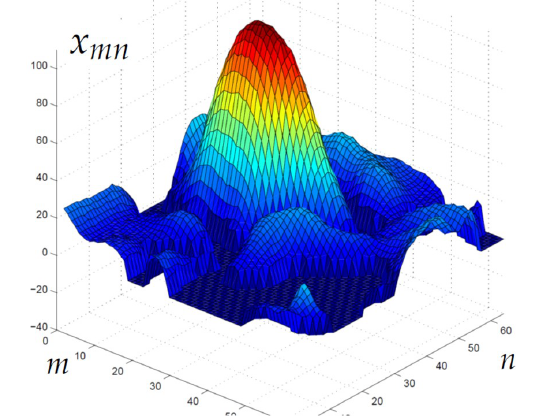
Figure 7. Oceanographic field ( N = 64 × 64 ).